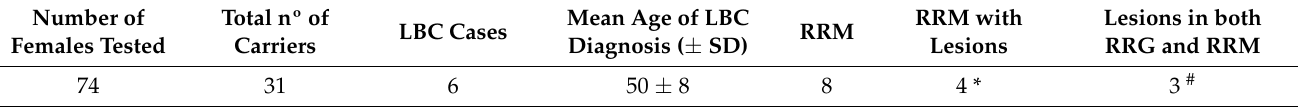
Footnote: * Two out of four female patients with RRM lesions were submitted to unilateral mastectomy, since they were previously diagnosed with LBC in the other breast; # all three patients were previously diagnosed with LBC and presented carcinoma foci in the RRM (on the other breast) and in the RRG. LBC, lobular breast cancer; RRM, risk reduction mastectomy; Age of diagnosis is represented by the mean of the affected carrier’s age ±